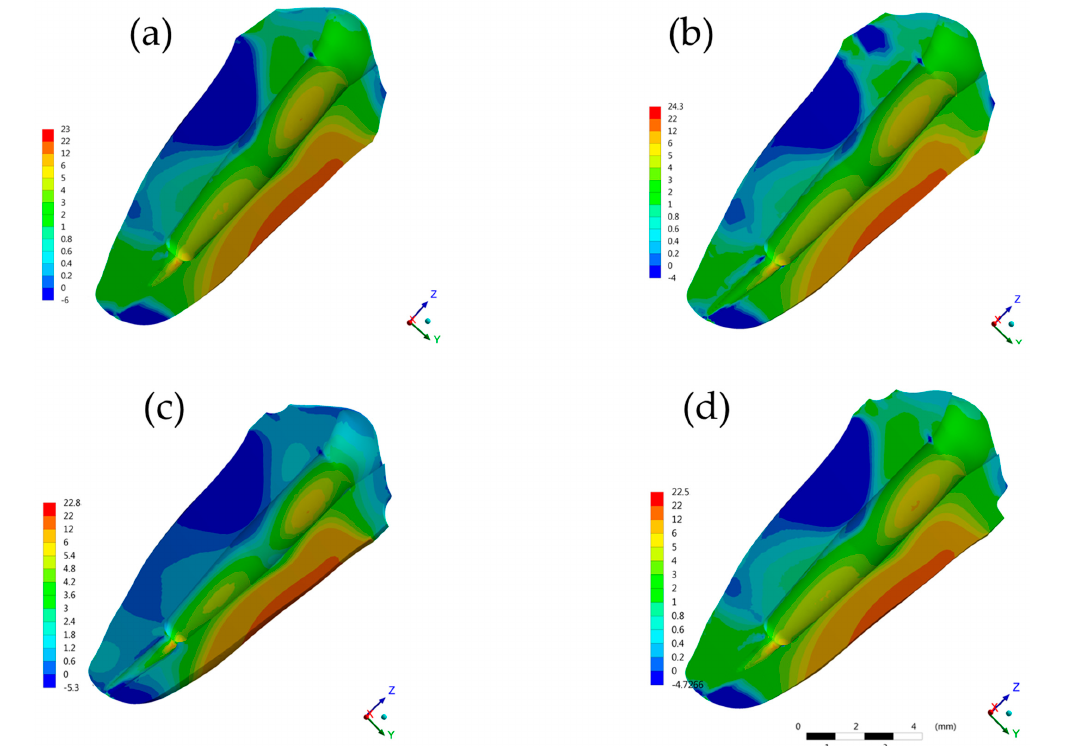
Figure 6. Contour plots of each restorative procedure first principal stress (MPa) in the root dentin. ( a ) BOPTB, ( b ) BOPT, ( c ) CM and ( d ) SM.